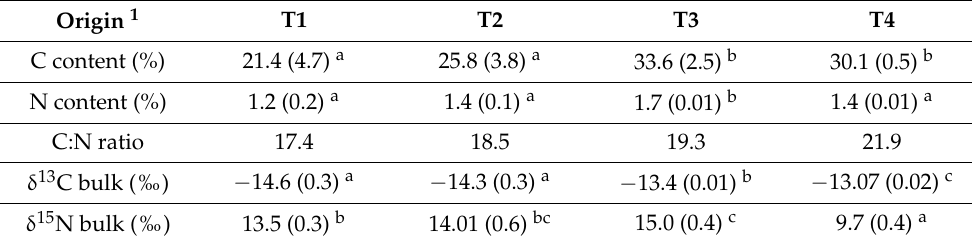
Table 3. Description of the compost samples: total C and N contents, C to N ratios, δ 13 C, and δ 15 N bulk isotopic data. Average values are as ( n = 2), including standard deviations (in